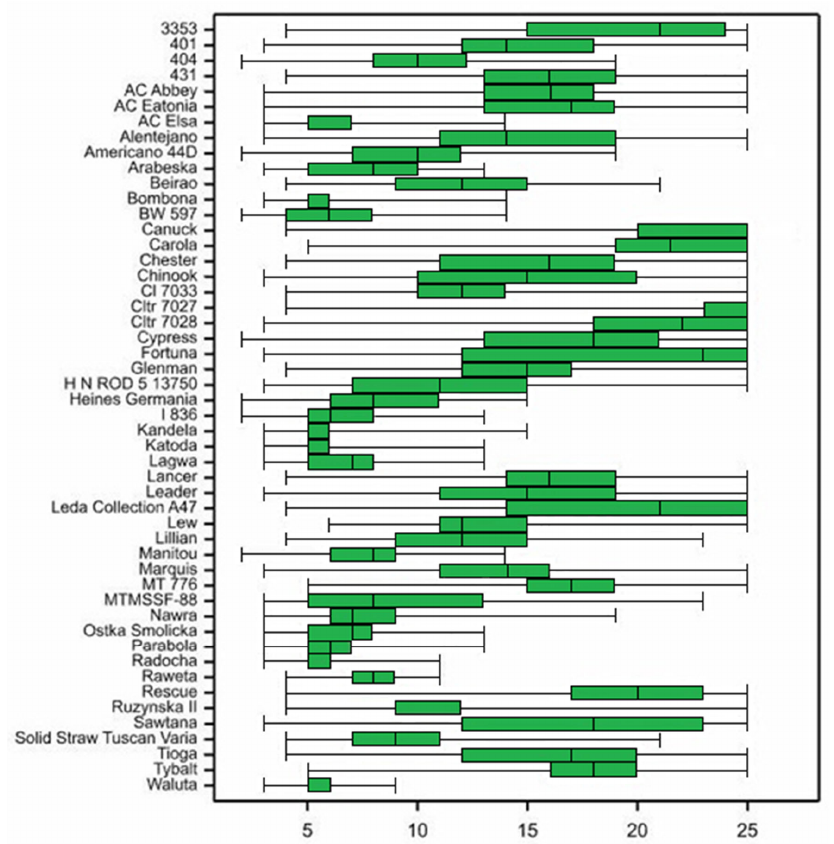
Figure 4. The range of variability of the stem-solidness in 50 spring wheat genotypes (Agricultural Research Station Dło´n, 2012–2014) assessed according to the methodology developed by DePauw and Read. The agglomerative clustering analysis with the Ward method showed that the divi ‐ sion of the cultivars into seven classes would be the most optimal method of grouping them according to the degree of their stem solidness (Table 3).